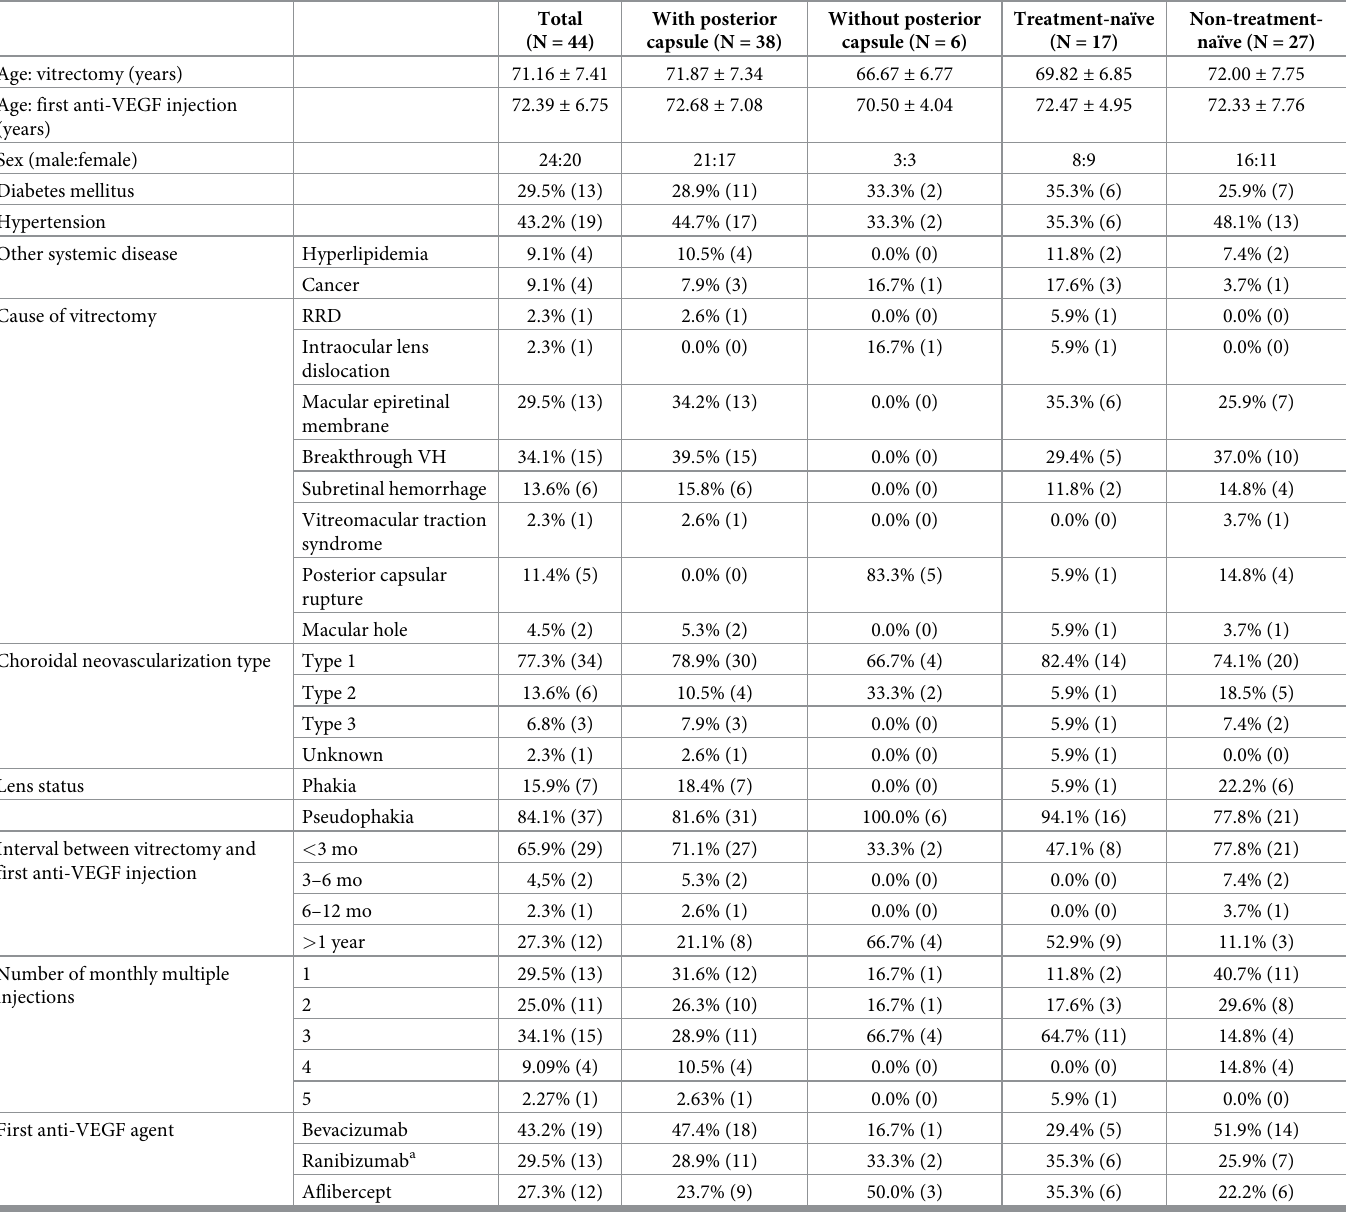
Table 1. Demographic and baseline characteristics of the 44 study